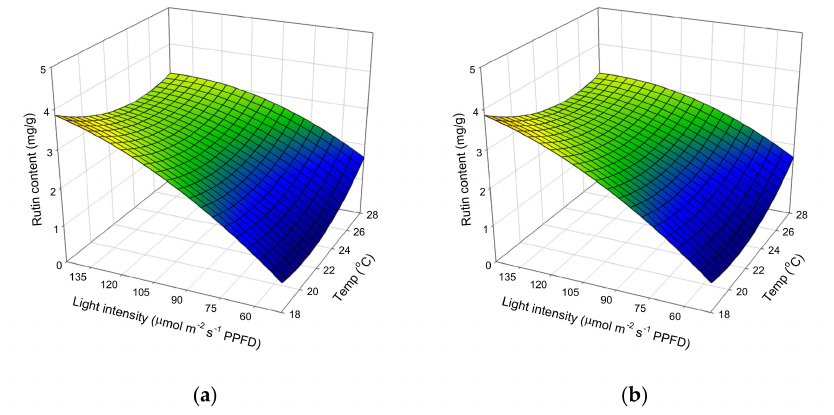
Figure 5. Response surface plot showing the e ff ects of cultivation ( a ) temperature, light intensity, and their mutual interaction on the rutin content; ( b ) light intensity, nutrients, and their mutual interaction on the rutin